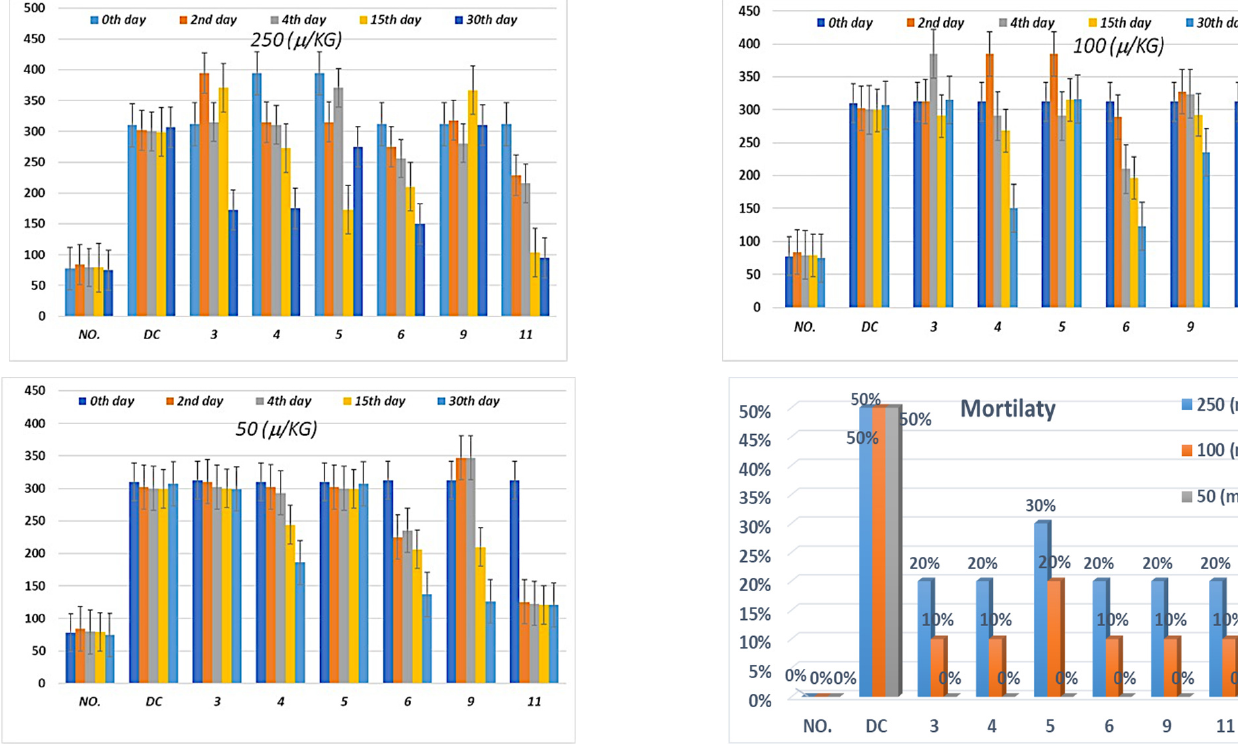
Figure 6. Antidiabetic effect and percent of mortality in three different concentration 50, 100, and 250 (µ/Kg) at 0th day (pre-drug values), 2nd and 4th day (post-drug values) for each group of compounds ( 3–6,9,11 ) compared to diabetic- control “DC” and normal control “NO”. Data analyzed by one way ANOVA followed by LSD test and expressed as mean ± SEM from five observations.